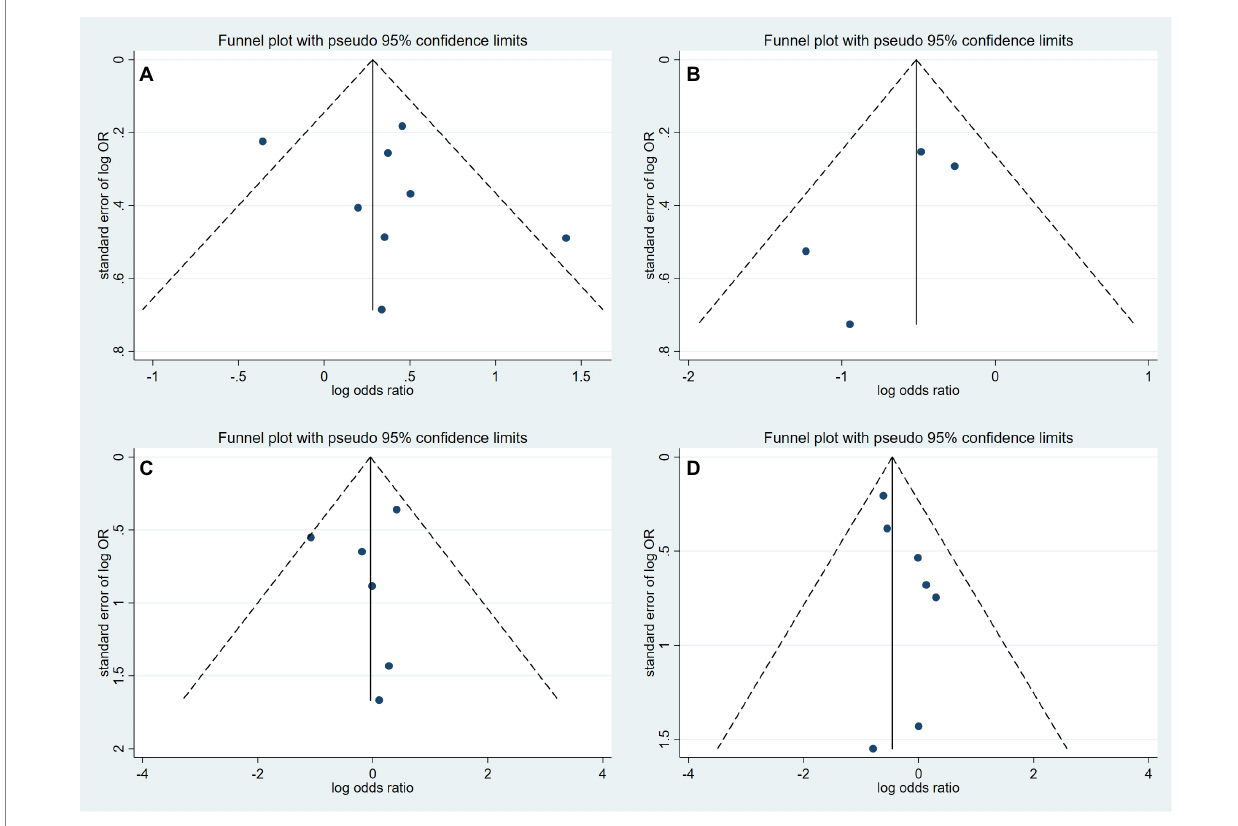
FIGURE 3 Funnel plot of meta-analysis of thrombectomy outcomes. (A) Favorable functional outcome. (B) ICH. (C) sICH. (D)